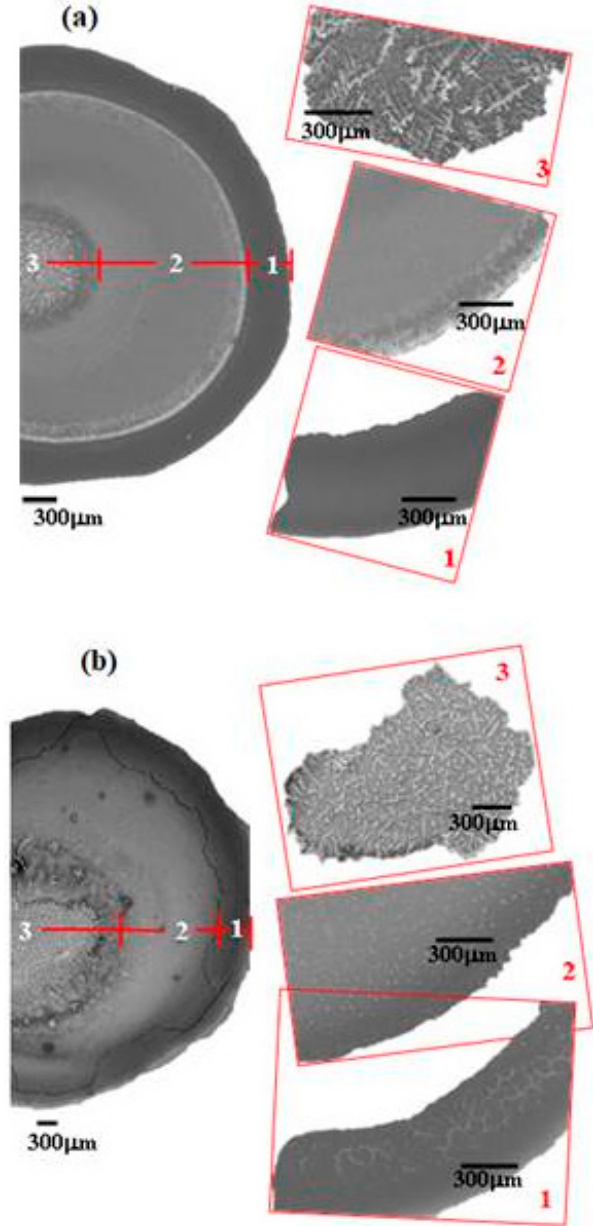
Figure 3. Dried droplets of PDADMAC–SLES ( a ) and PDADMAC–SLMT ( b ) mixtures, with surfac- tant concentrations of 2.6 and 2.9 mM, respectively, illustrating the three distinct regions.